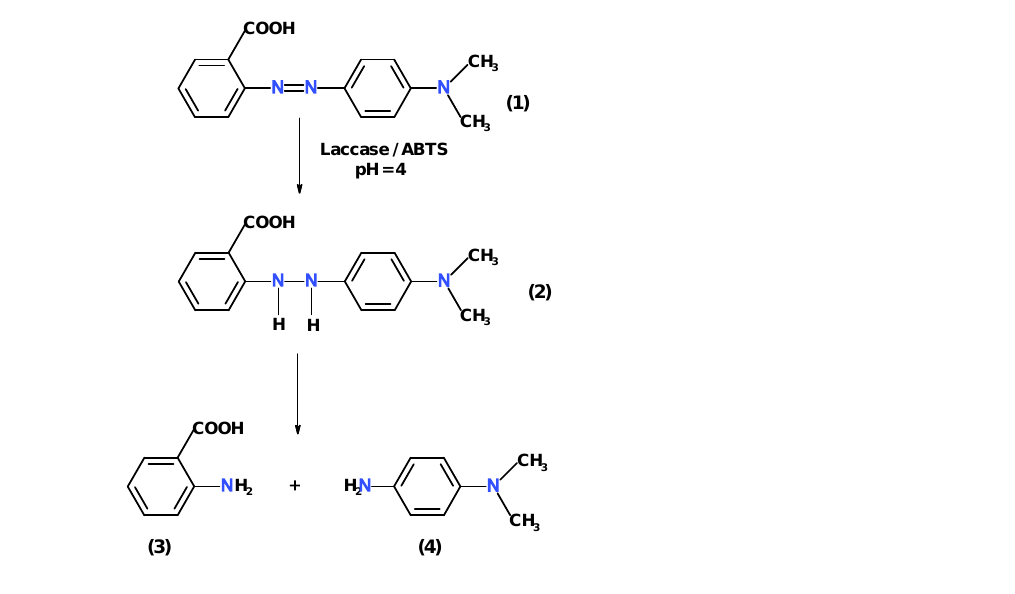
Figure S3. The FT-ICR-MS spectra of MR (A. Buffer, B. MR, and C. Simulated spectra of MR); Figure